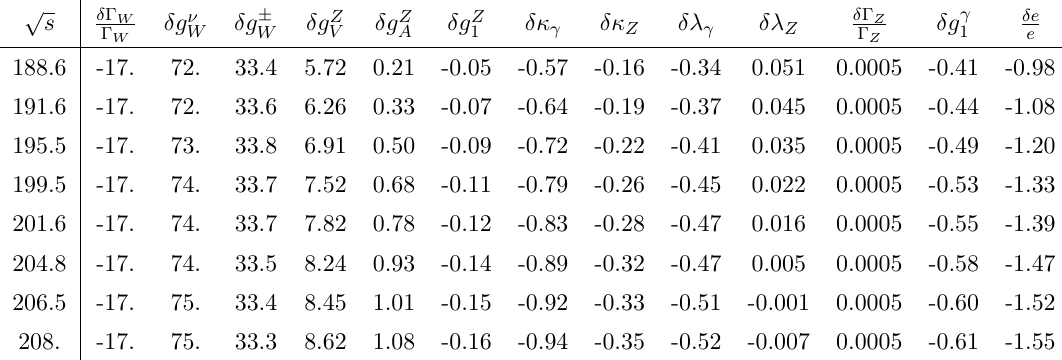
(cid:22) (cid:22) production due to common shift Table 3 . Total cross section contributions (in pb) to (cid:22) ! parameters, in the ^ m W ; ^ m Z ; ^ G F scheme. The results are normalized for semileptonic (cid:12)nal states: f g they should be multiplied for 1.01 (1/4.04) for fully hadronic (leptonic) (cid:12)nal states. The quantity (cid:14)g (cid:23) = (cid:14)g ‘ corresponds to the shift in the W (cid:6) coupling to e + e (cid:0) in the t -channel diagrams, while W W the column (cid:14)g (cid:6) = (cid:14)g q=‘ accounts for the shift in each W (cid:6) coupling to a pair of (cid:12)nal state fermions. W W